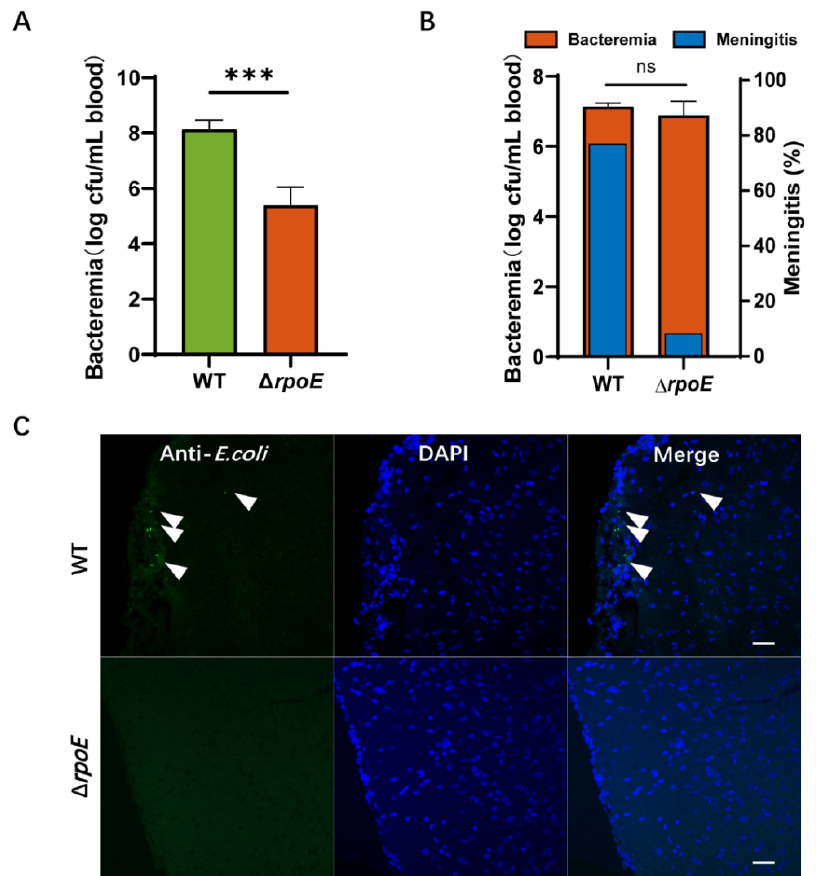
Figure 2. Deletion of rpoE reduces RS218 survival in the blood and penetration of the blood–brain barrier (BBB). ( A ) Magnitude of bacteremia in BALB/c mice. Bacterial counts in the blood (log CFU/mL) were determined. ( B ) Blood samples were collected for bacteremia measurement, and cerebrospinal fluid (CSF) was collected and cultured to assess the passage of bacteria through the BBB. ( C ) The brains were collected after the mice were intravenously inoculated with bacteria and were sectioned for immunofluorescent staining. E. coli K1 (green) and nuclei (blue) are shown. Arrows indicate bacteria. Scale bar, 20 µ m. The data represent the mean ± standard deviation from three independent experiments performed in triplicate. *** p < 0.001 by Student’s t -test, ns, not